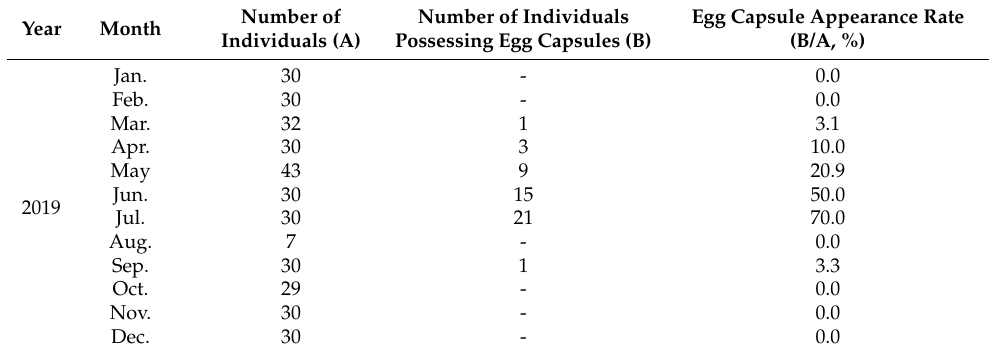
Table 2. Egg capsule appearance rate in female Okamejei kenojei collected from the West Sea of South